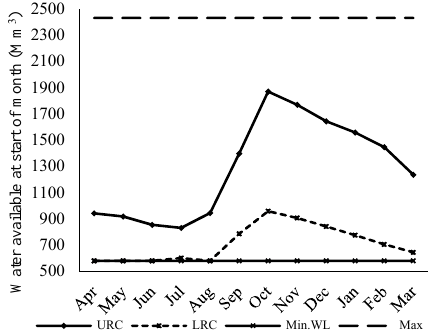
Figure 2. Rule curves for Ubonratana